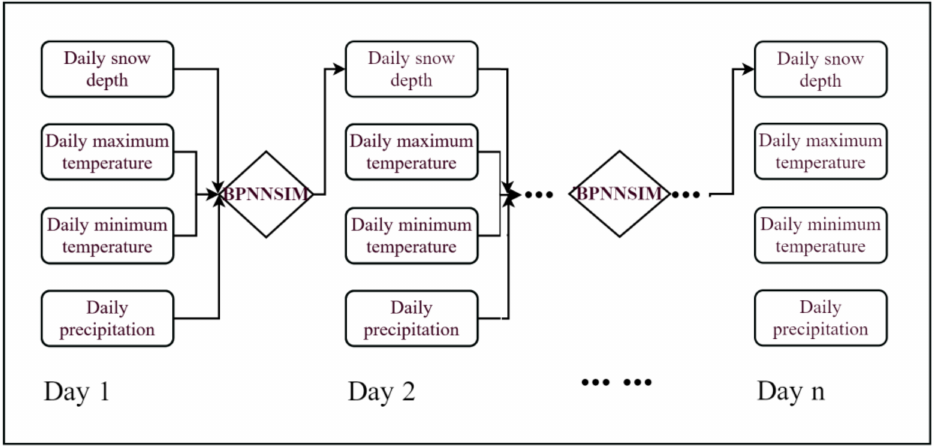
Figure 4. BPNNSIM iterative simulation